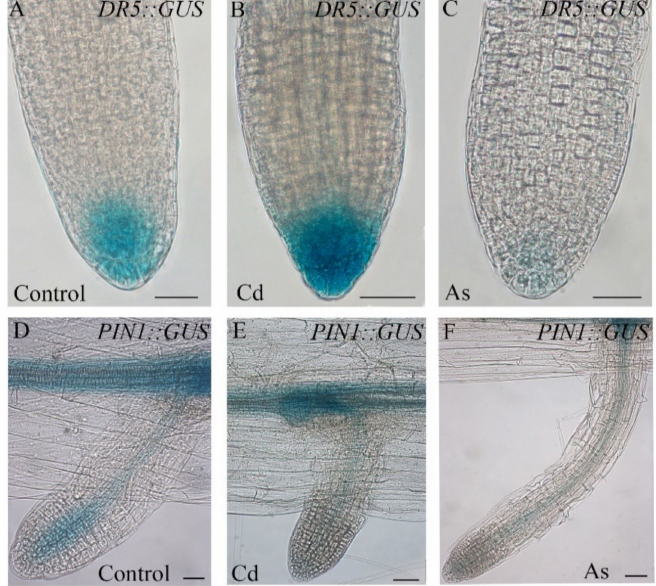
Figure 2. Expression patterns of DR5::GUS and PIN1::GUS in lateral roots (LRs) of Arabidopsis DR5::GUS and PIN1::GUS seedlings non-exposed (Control, ( A , D )) or exposed to 60 µ M CdSO 4 (Cd, ( B , E )) or 400 µ M Na 2 HAsO 4 · 7H 2 O (As, ( C , F )). Bars = 20 µ m ( A – C ), 30 µ m ( D ) and 50 µ m ( E – F